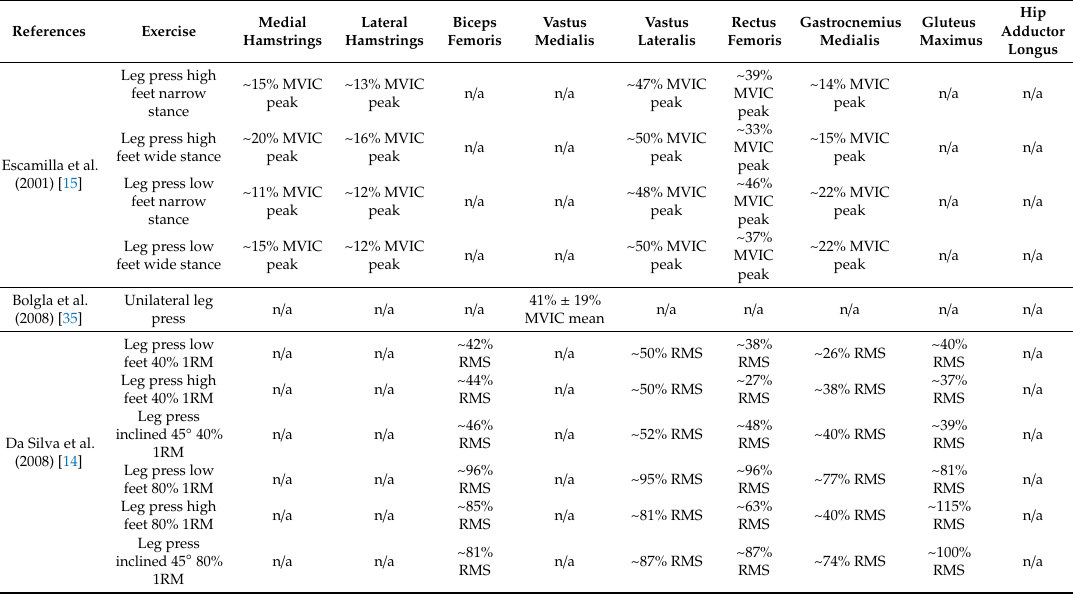
Table 3. Data on sEMG activity in studies comparing the leg press with some of its